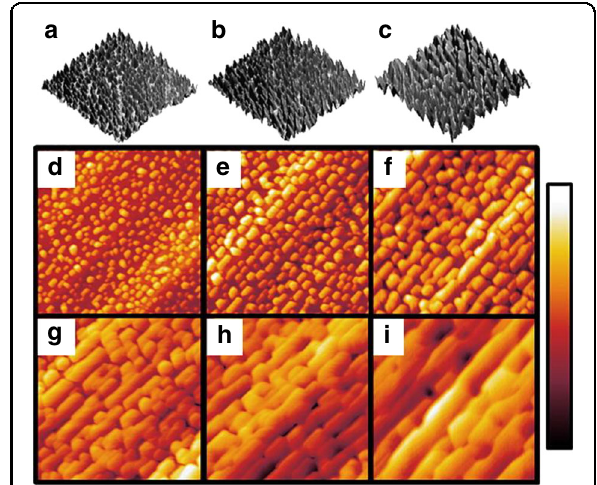
Fig. 3 Atomic force micrographs of InN on N-polar GaN. Nominal InN thicknesses of ( a )/( d ) 1 nm, ( b )/( e ) 2 nm, ( c )/( f ) 3 nm, ( g ) 5 nm, ( h ) 10 nm, and ( i ) 20 nm. a – c Show 3D images whereas ( d ) – ( i ) depict top down images with the scale at the right as follows: − 5 to 5 nm for ( d ) – ( f ) and − 10 to 10 nm for ( g ) – ( i ). Reprinted from Reilly et al., Appl. Phys. Lett. 114 , 241103 (2019) with permission of AIP Publishing 78 . Adapted from Lund et al., J. Appl. Phys. 123 , 055702 (2018) with permission of AIP Publishing